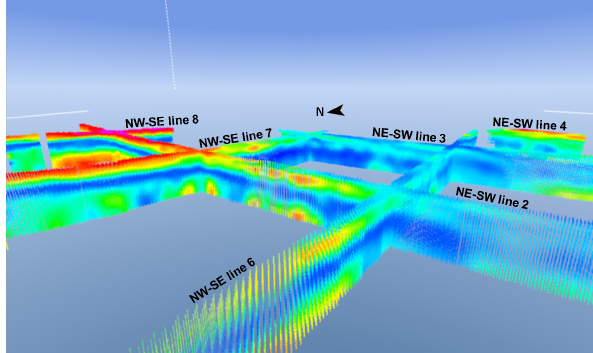
Figure 6. 3D geological model of the Nasia sub-basin resulting from the combined interpretation of the B-field airborne data, the prior geological knowledge of the area, and the available